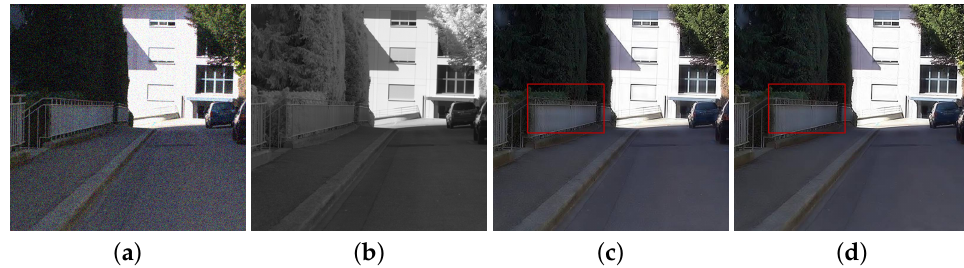
Figure 16. Fusion results from the MFD framework under DWT and DTCWT. ( a ) Noisy RGB image. ( b ) NIR image. ( c ) Fusion under DWT. ( d ) Fusion under DT-CWT.